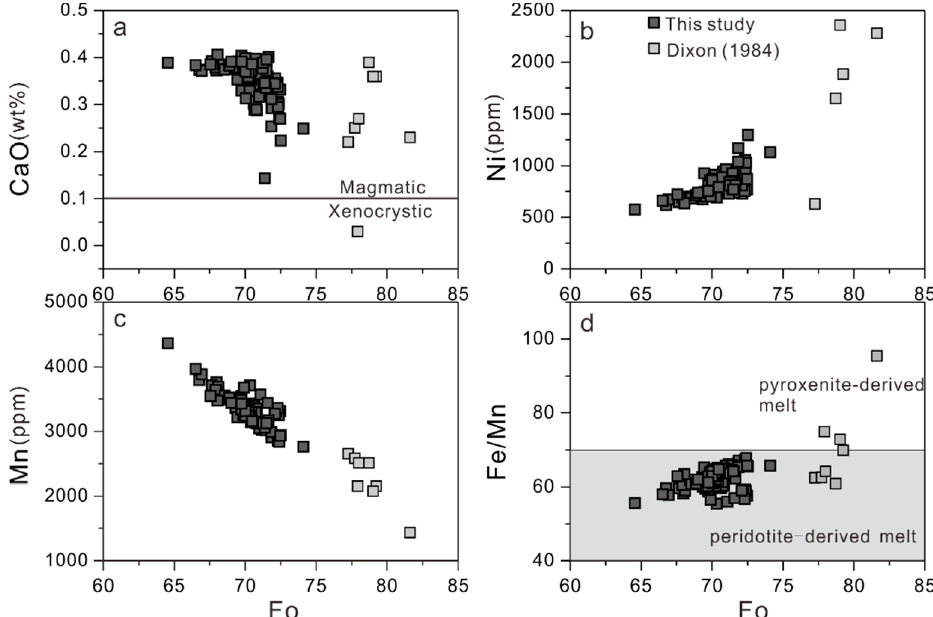
Figure 6. Pohnpei basalt olivine CaO ( a ), Ni ( b ), Mn ( c ) contents, and Fe/Mn ratios ( d ) vs. Fo values. Data for Pohnpei olivines from Dixon et al. [9] are plotted for comparison. Data for Pohnpei olivines from Dixon et al. [9] are plotted for